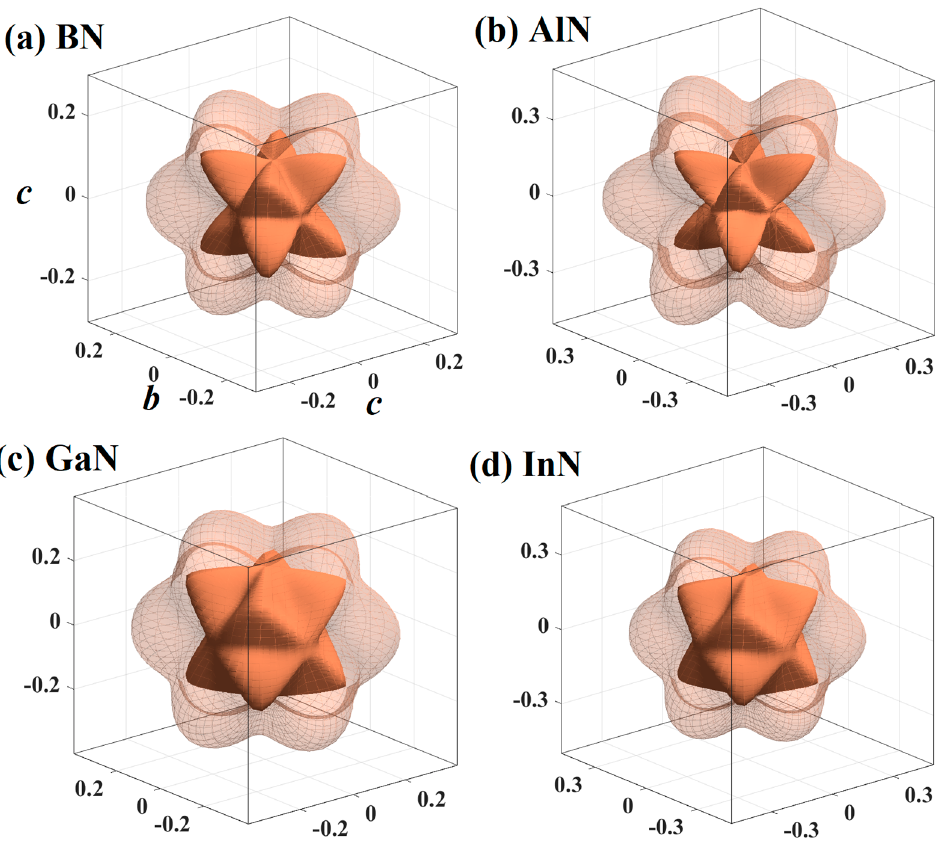
Figure 7. The 3D silhouette maps of the v for BN ( a ), AlN ( b ), GaN ( c ), and InN ( d ) in the Pm − 3 n phase.